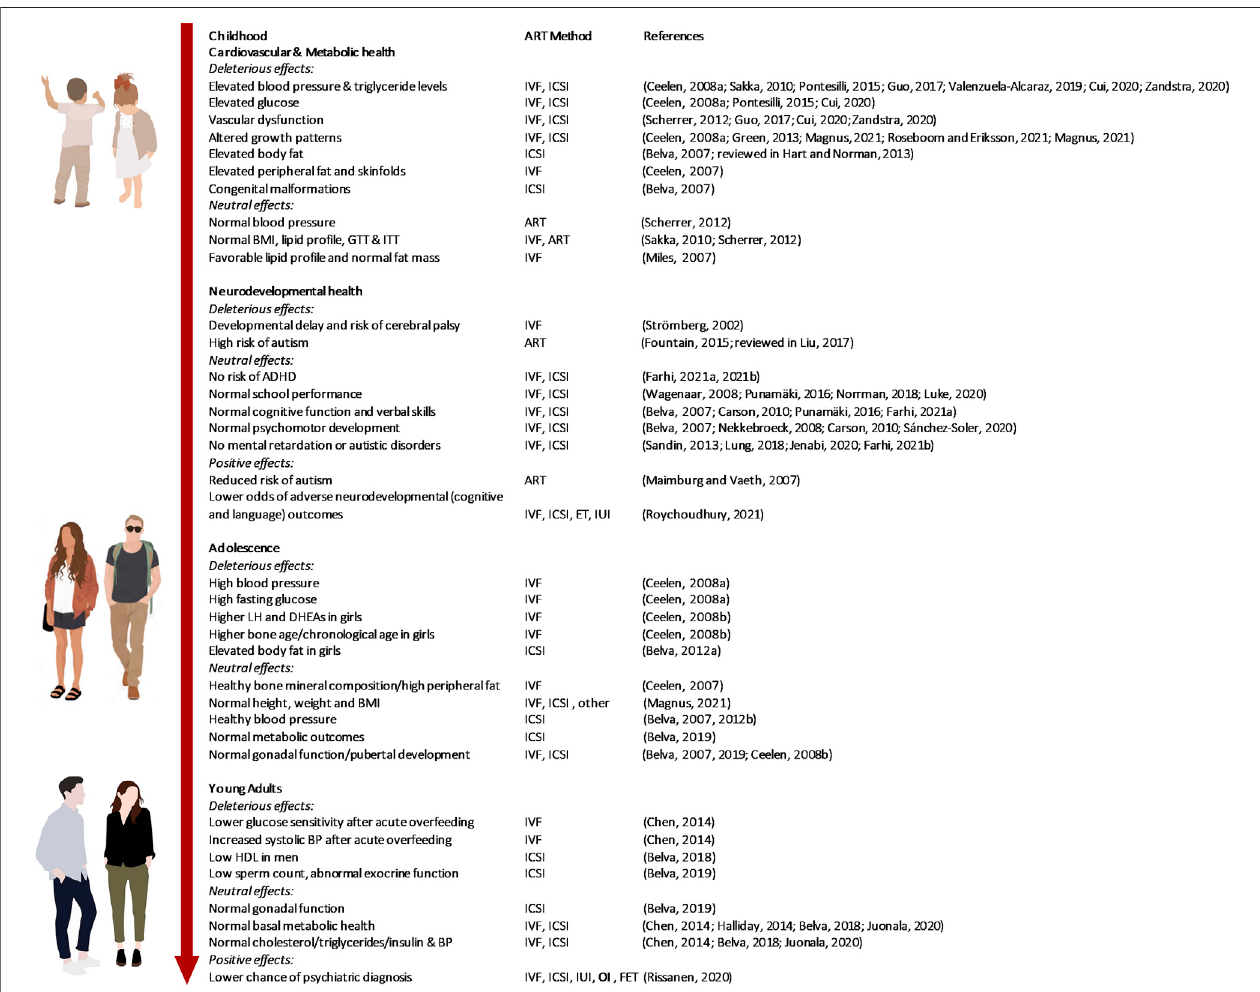
FIGURE 2 | The effect of the use of ART on childhood, adolescent and adult health outcomes. Legend: LH: Luteinizing Hormone; DHEAS: Dehydroepiandrosterone sulfate; HDL: High-density lipoprotein; ADHD: Attention-de fi cit/hyperactivity disorder; BP: Blood pressure; BMI: Body Mass Index, GTT: Glucose Tolerance Test, ITT: Insulin Tolerance Test, ET: Embryo